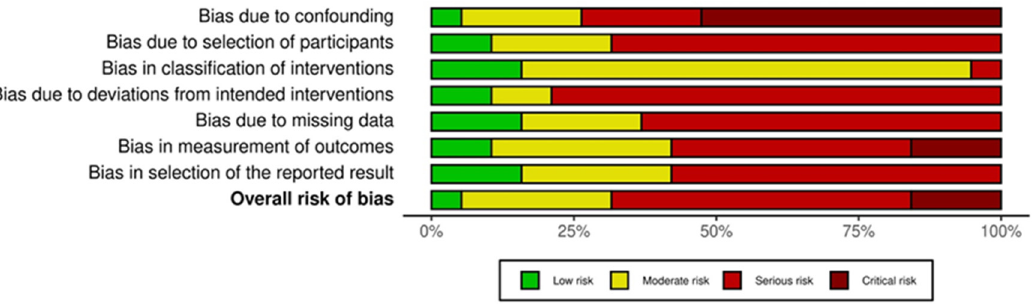
Figure 7. Risk of Bias in Non-Randomized Studies—of Interventions (ROBINS-I) summary